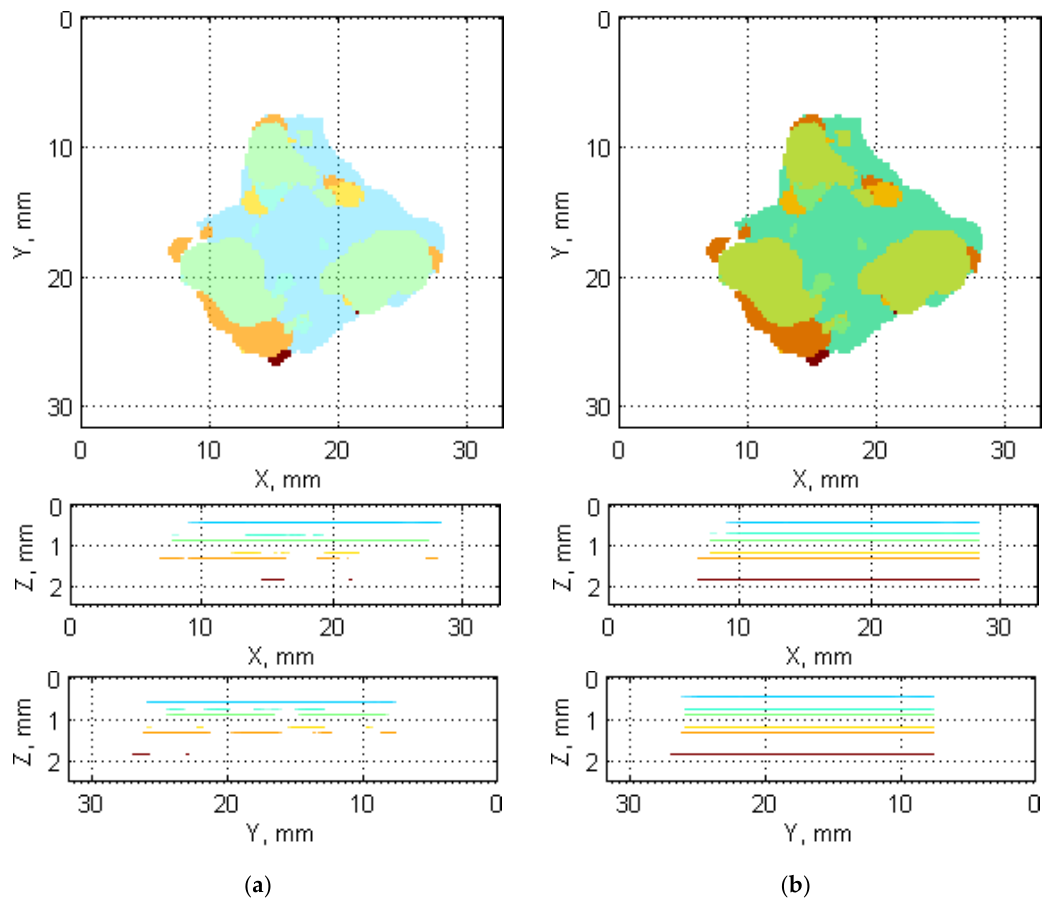
Figure 13. Visualization of the reconstructed damage based on UT C-Scans: ( a ) without gaps filling; ( b ) with gaps filling.